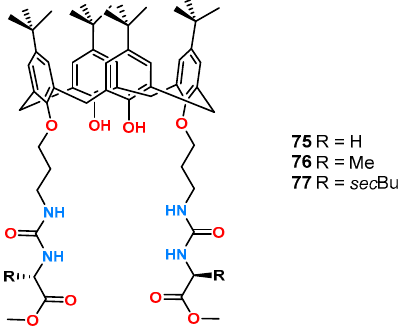
Figure 26. C 2 -Symmetrical calixarene diurea receptors 75–77 .